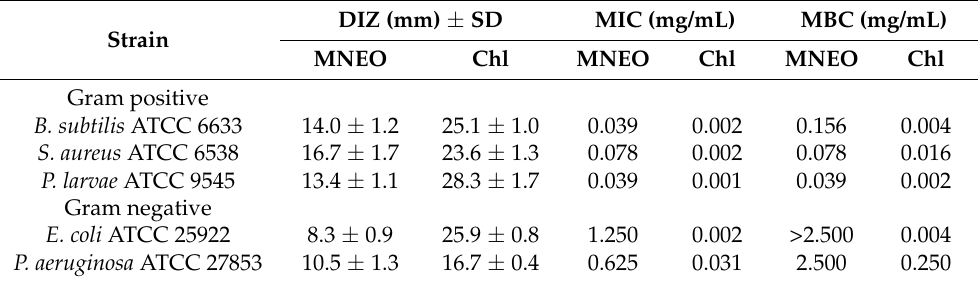
Table 2. Diameter of the inhibition zones (DIZ), minimum inhibitory concentrations (MIC) and minimum bactericidal concentration (MBC) of the essential oil of M. nepalensis (MNEO). DIZ (mm) ± SD MIC (mg/mL) MBC (mg/mL) Strain Chl